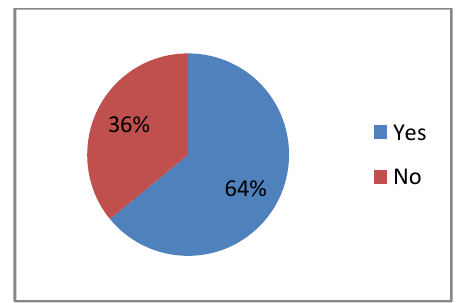
Fig. 2: Toilet facilities in the communities